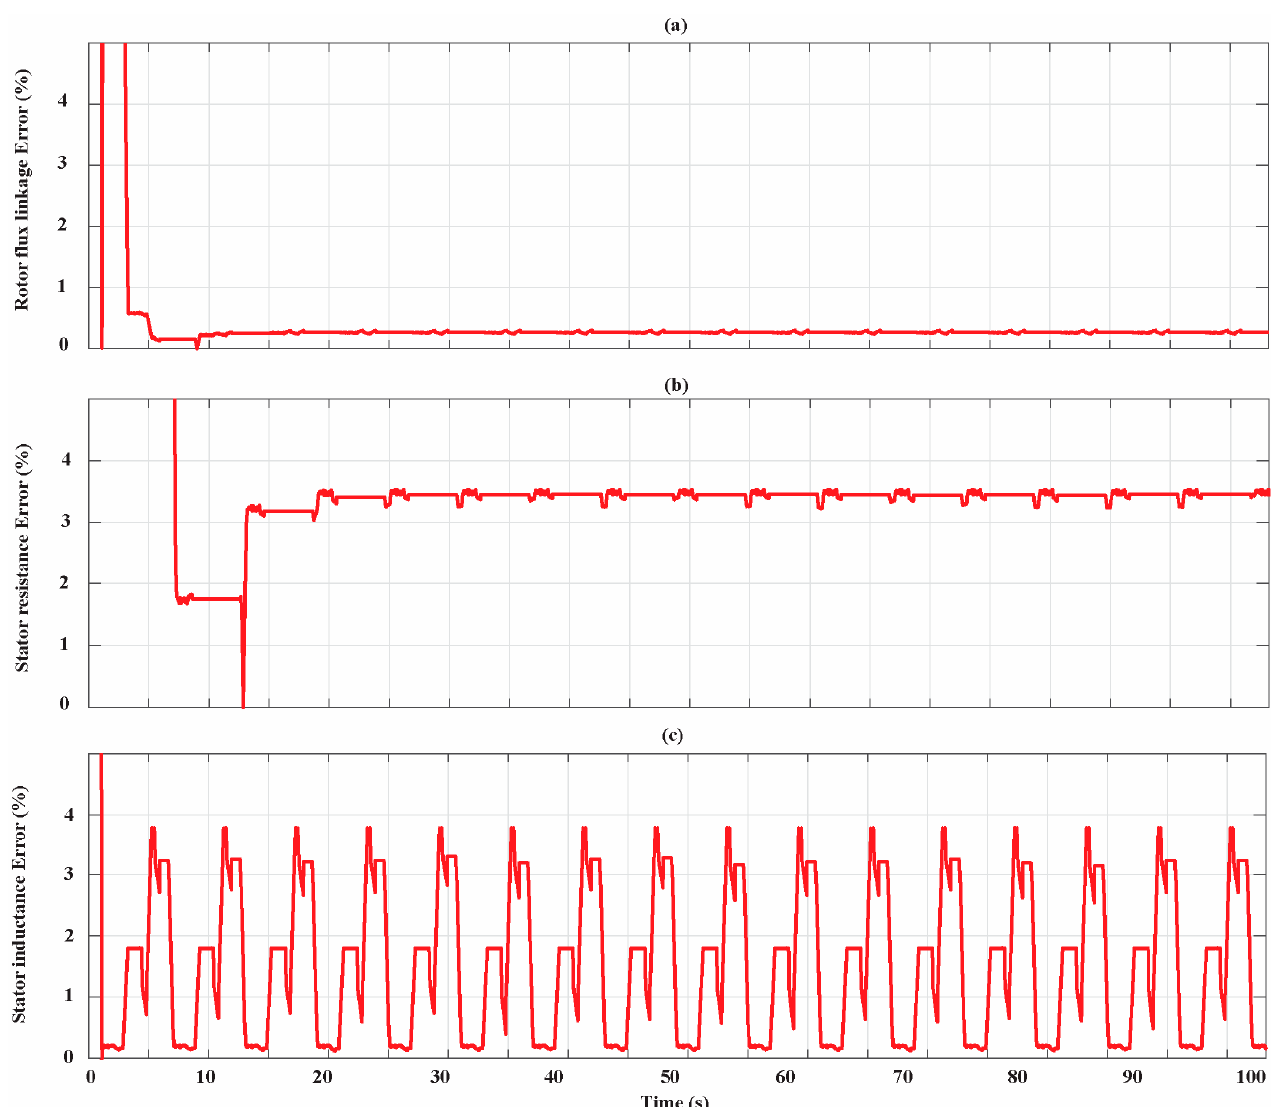
Figure 15. Percentage estimation error for the Bonfiglioli 170. ( a ) Rotor flux linkage estimation error; ( b ) stator resistance estimation error; ( c ) stator inductance estimation error.